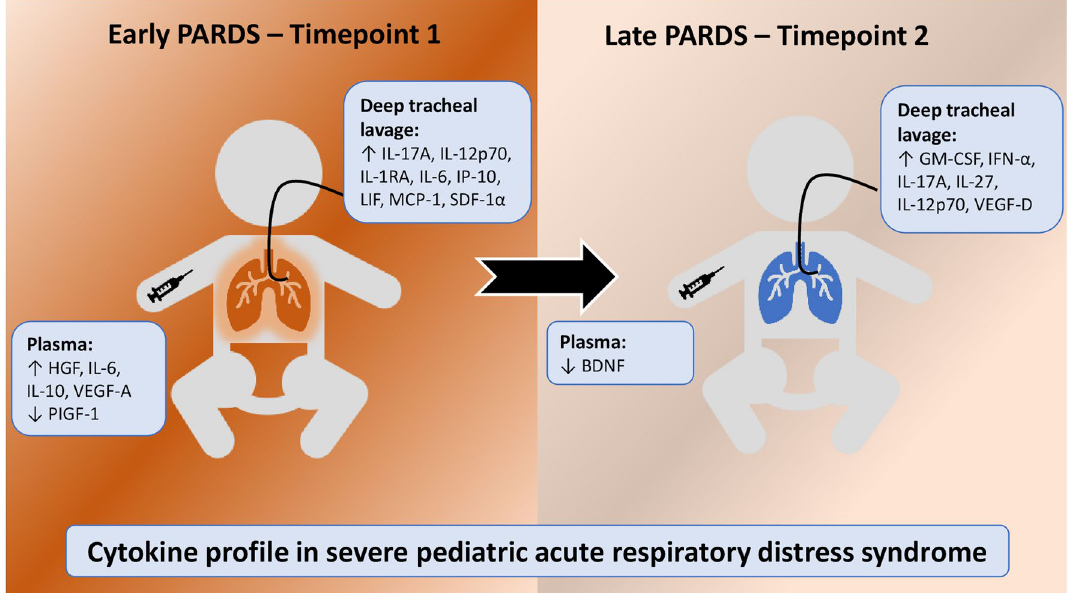
Figure 5. Cytokine profile in severe pediatric acute respiratory distress syndrome. PARDS pediatric acute respiratory distress